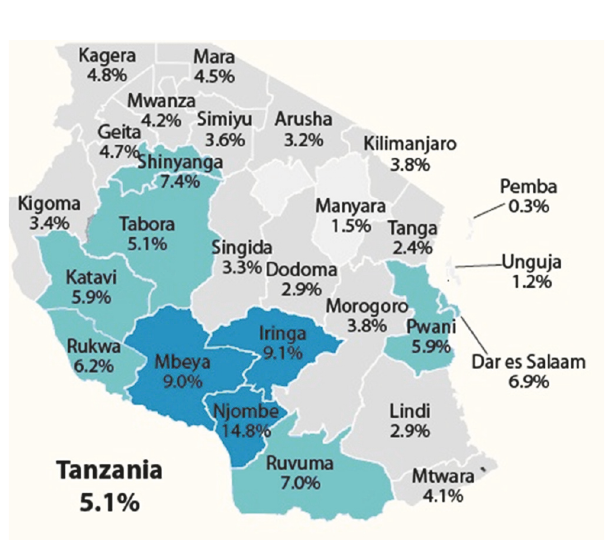
Figure 1: HIV prevalence among men and women aged 15–49 years in Tanzania by region [2]. Source : Tanzania HIV/AIDS and Malaria Indicator Survey